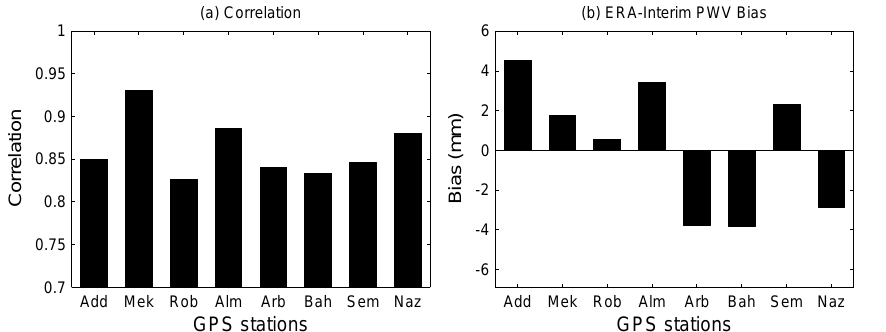
Figure 9. Correlation coefficients of individual observations between ERA-Interim and GPS (a) and bias in ERA-Interim with respect to GPS (b) for all eight ground GPS receiver